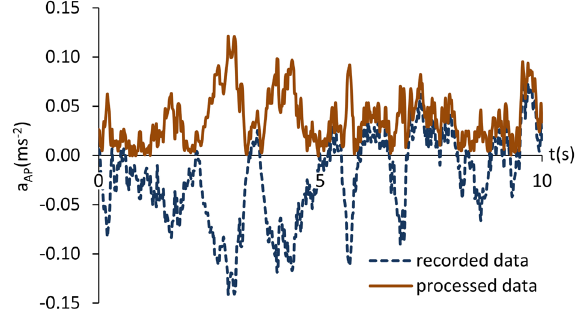
Figure 2. Example of recorded/calculated anterior- posterior acceleration and processed anterior-posterior